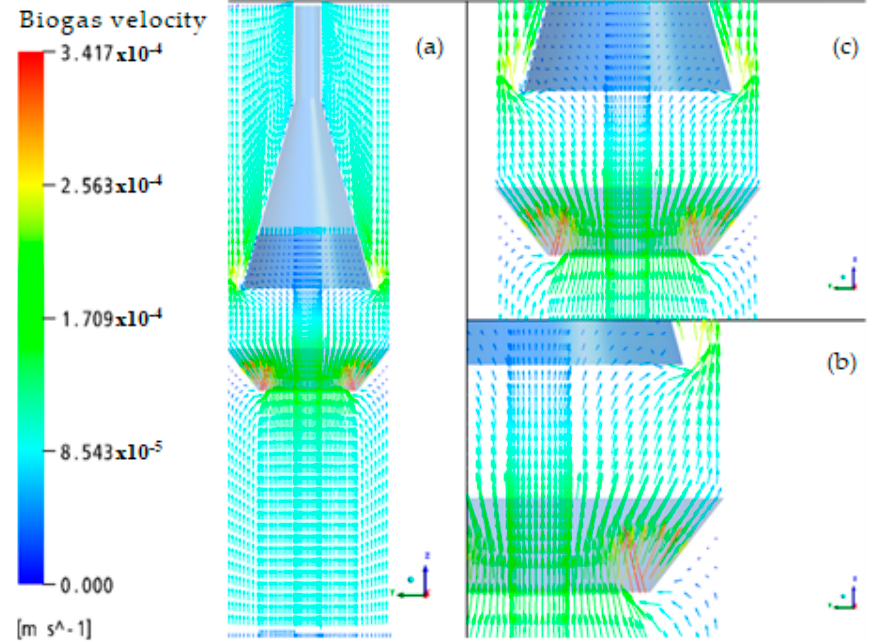
Figure 9. Water velocity vector in the reactor with deflector inclination downwards: ( a ) overview, ( b ) detail of the region between the gas deflector and the three-phase separating element, and ( c ) detail of the region corresponding to the settling zone. Water 2020 , 12 , 279